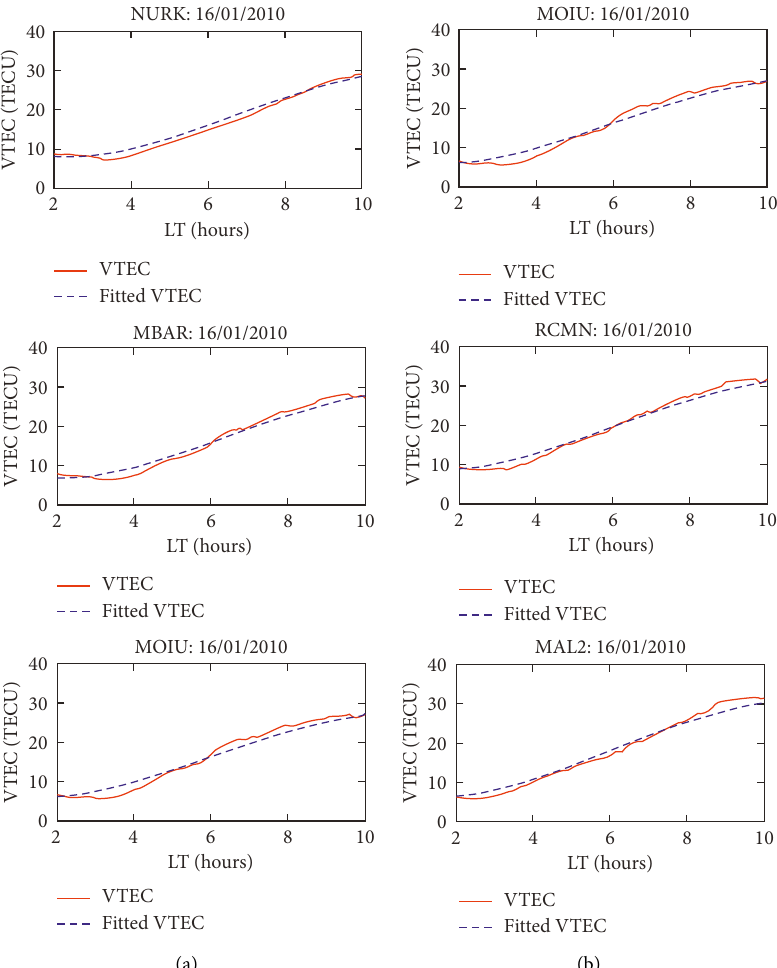
Figure 9: VTEC and fitted VTEC against local time (LT) across (a) NURK-MBAR-MOIU and (b) MOIU-RCMN-MAL2 GPS array on 16 th January